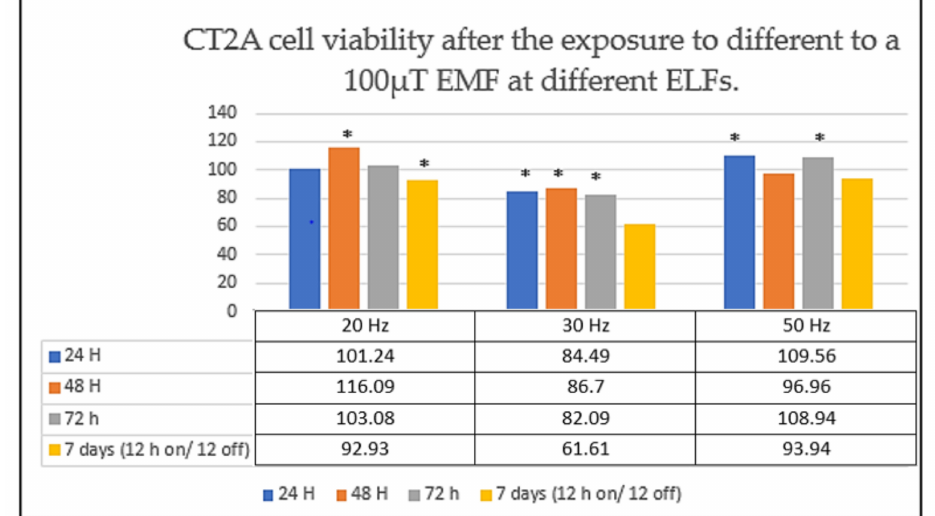
Figure 4. CT2A cell viability after the exposure to different non-ionizing EMFs. CT2A cells were exposed to a 100 µ T EMF during 24 h (continuous exposure), 48 h (continuous exposure), 72 h (continuous exposure) and 7 days (intermittent exposure: 12 h coils on/12 h coils off) to three ELFs: 20, 30 and 50 Hz. The data are expressed as the means ± standard error, and * indicates a significant cell viability difference from the CT2A control group ( p < 0.05)